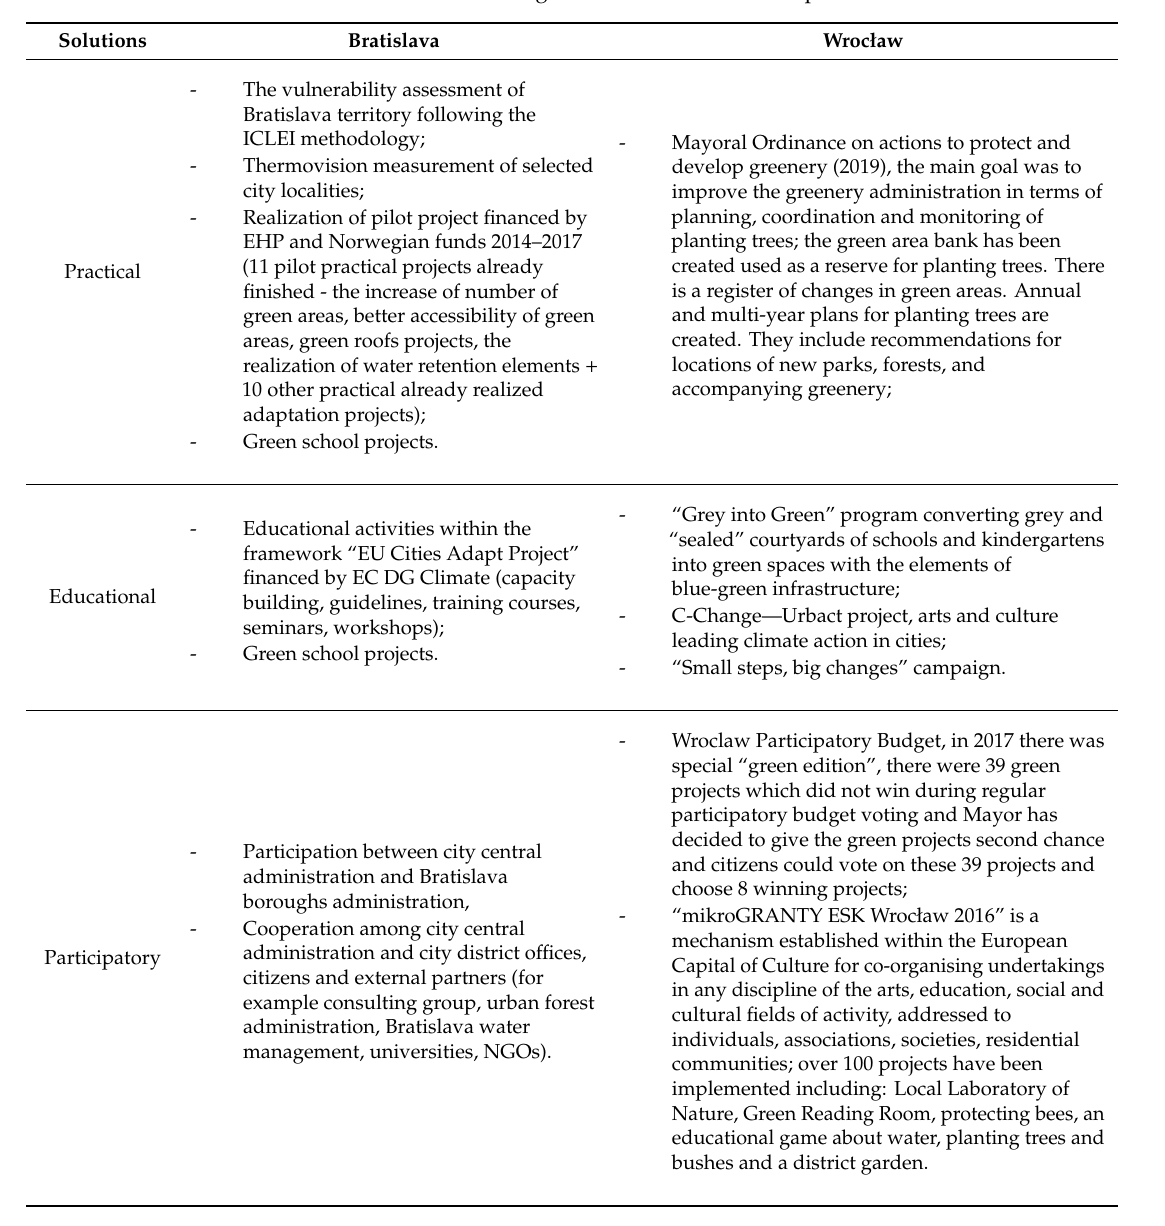
Table 2. Local solutions of green infrastructure